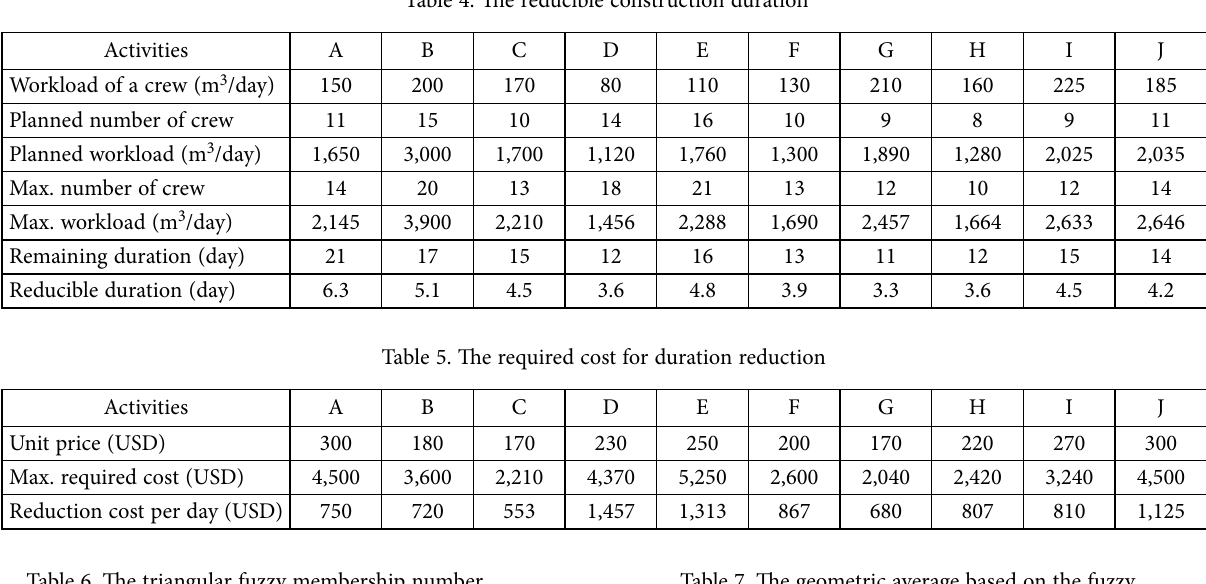
Table 6. The triangular fuzzy membership number Table 7. The geometric average based on the